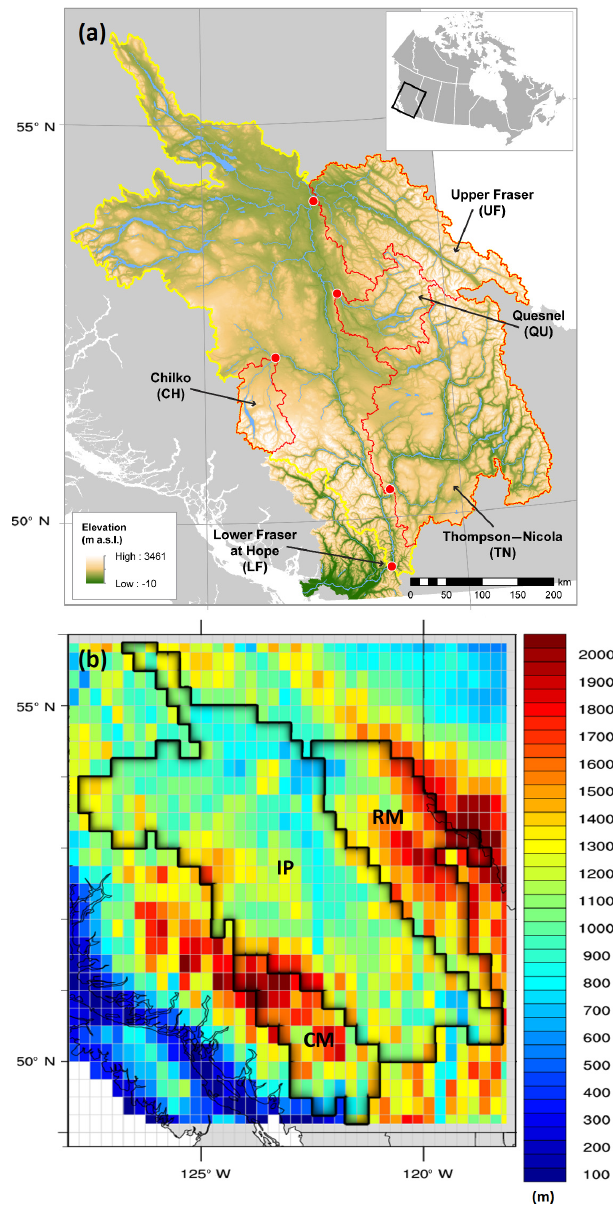
Figure 1. (a) Digital elevation model of the FRB with identifica- tion of sub-basins: upper Fraser (UF), Quesnel (QU), Chilko (CH), Thompson–Nicola (TN) and Fraser at Hope (LF). (b) Elevation map highlighting the Fraser River Basin and three geoclimatic regions. RM, IP and CM represent the Rocky Mountains, Interior Plateau and Coast Mountains, respectively. Elevations are in metres, and the horizontal grid resolution is that of the VIC hydrological model (0.25 ◦